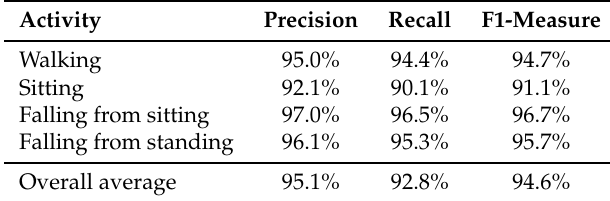
Table 3. The recognition results of the four fall-related activities from fully-observed video sequences.